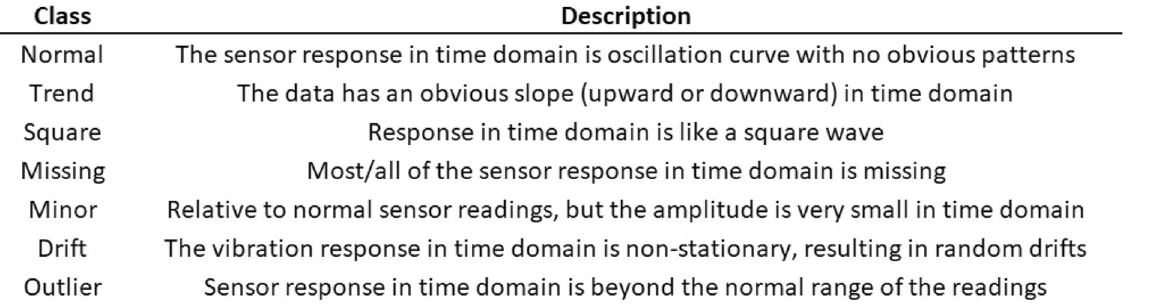
Table 1 Description of each data